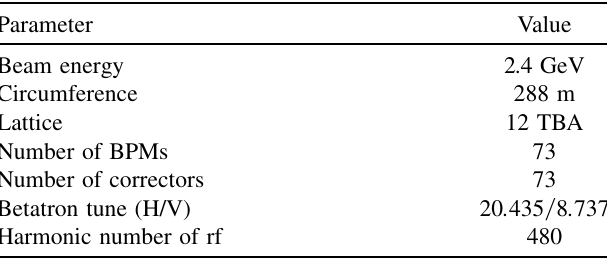
TABLE I. SLS storage ring